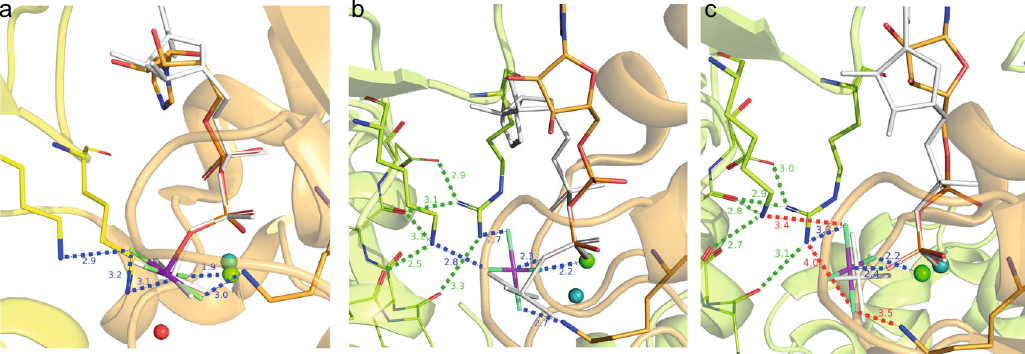
Fig. 6 The transition-state analogue AlF 4 − can adopt different orientations in diverse P-loop ATPases of the ASCE division. a AlF 4 − binding in RecA from E. coli (PDB accession code 3CMW 110 ). The P-loop domain (NBD domain) is shown in orange, the NBD domain of the adjacent activating subunit that provides the stimulating “ fi ngers ” is colored yellow. The magnesium ion is shown as a green sphere. To show the catalytic water molecule H 2 O cat , the ADP:AlF 4 − complex is superimposed with the structure of the ADP:AlF 4 − :H 2 O cat complex from the ABC ATPase of the maltose transporter MalK (see PDB accession code 3PUW 111 ). The ADP molecule and AlF 4 − of MalK are shown in white, H 2 O cat as a red sphere, Mg 2 + as a teal sphere. ADP moieties were superimposed using atoms O 3A , P B and O 3B (see Fig. 3b for the atom notation used for ADP) in Pymol 112 . b Coordination of AlF 4 − in the Bst DnaB structure (see Supplementary Fig. 10, PDB ID 4ESV and ref. 21 ). The orange, nucleotide-binding chain and the green activating chain correspond to the chains C and B of the 4ESV 21 . To show the displacement of AlF 4 − , the GDP:AlF 4 − complex is superimposed, as described for panel a , with ADP:AlF 4 − bound to the RecA protein (PDB ID 3CMW, see panel a ). The H-bonds formed by AlF 4 − are shown in blue, the additional interactions that stabilize the position of stimulating sidechains of K418 and R420 are shown in green. The AlF 4 − moiety is twisted in comparison to the transition-state-mimicking complex shown on panel a . c Coordination of AlF 4 − in the structure of Bst DnaB (see Supplementary Fig. 10, PDB ID 4ESV 21 ). The orange, nucleotide-binding chain and the green activating chain correspond to the chains F and E of the 4ESV PDB structure 21 . To show the further displacement of AlF 4 − , the GDP:AlF 4 − complex of subunit F is superimposed, as described for panel a , with the same complex bound to subunit C of the 4ESV PDB structure 21 , which is white coloured (see panel b ). Bonding interactions that are observed for the GDP:AlF 4 − complex trapped at the B/C interface (see panel b ), but not in this complex trapped at the E/F interface are shown as red dashed